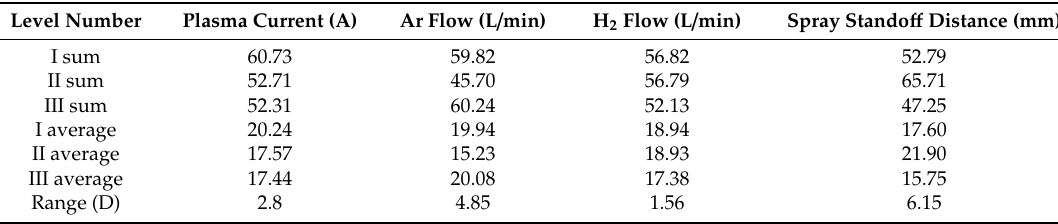
Table 4. Range analysis of the bond strength of the AT13 coatings prepared at three levels.